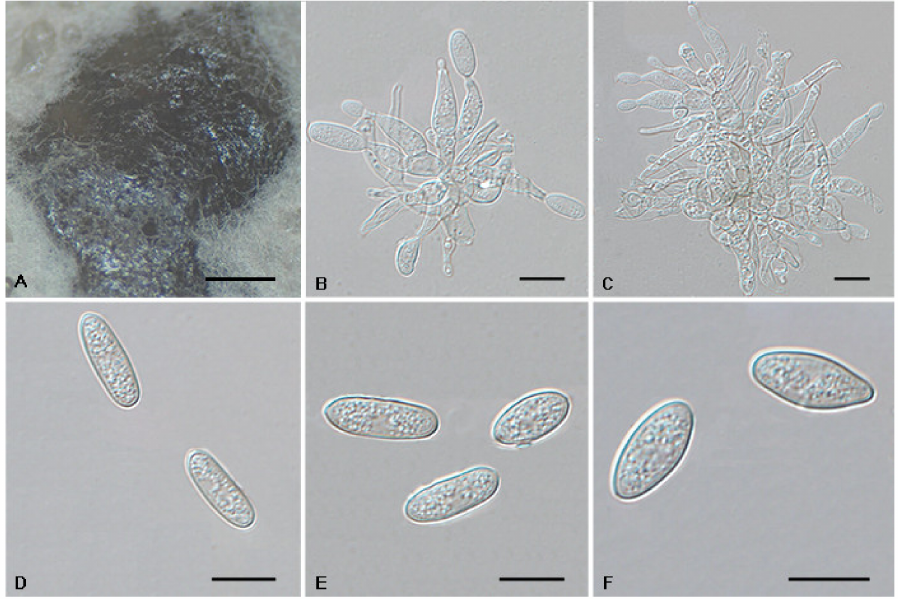
Figure 11. The morphology of Tubakia paradryinoides (CFCC 55984). ( A ) Conidiomata formed on PDA; ( B – C ) Conidiogenous cells giving rise to conidia; ( D – F ) Conidia. Scale bars: ( A ) = 100 µ m; ( B – F ) = 10 µ m. Description: Oak seeds rot, forming crustose conidiomata on the surface of leaves and causing leaf spots. In vitro: Conidiomata sporodochial, appeared within 10 days or longer, formed on the agar surface, slimy, black, semi-submerged, 200–750 µ m diam. Conidiophores reduced to conidiogenous cells. Conidiogenous cells originating